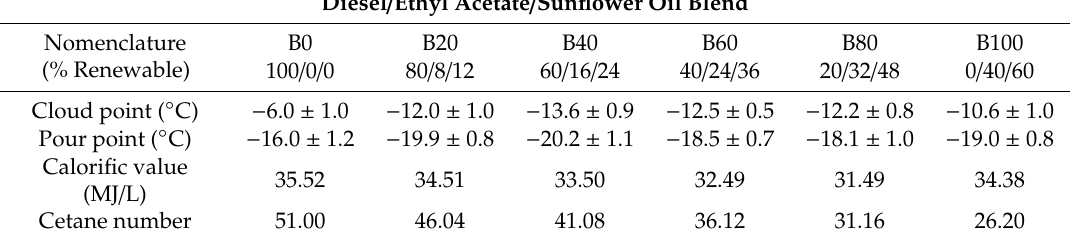
Table 5. Cloud point, pour point, calorific value and cetane number of diesel / ethyl acetate / sunflower oil triple blends (EA = 40%). Errors have been calculated from average three measurement and expressed as standard deviation.